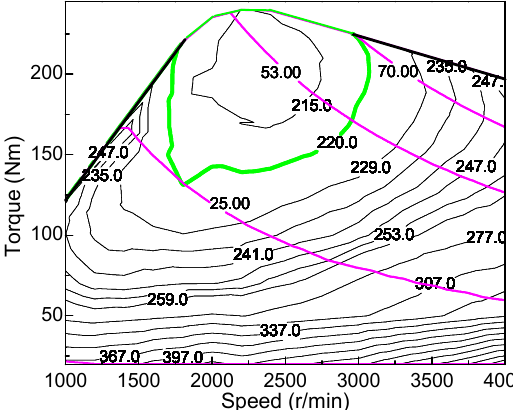
Figure 2. Engine fuel consumption contour map.